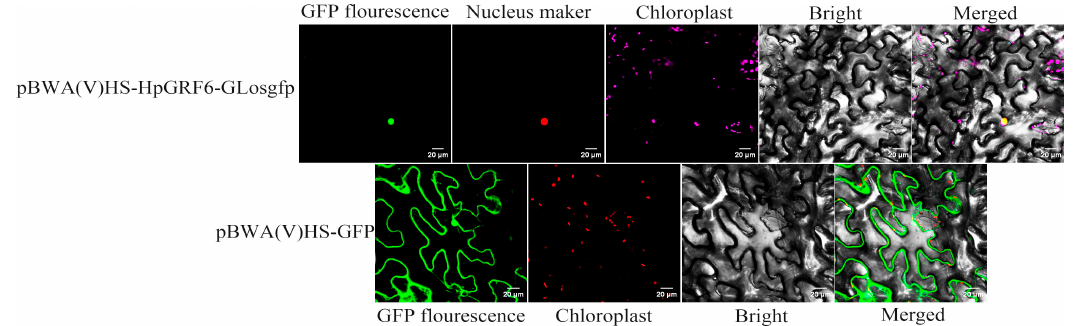
Figure 7. Subcellular localization of HpGRF6 in tobacco leaves. The construct of HpGRF6 fused with the N-terminal of green fluorescence protein (GFP; pBWA(V)HS-HpGRF6-GLosgfp) was co-infiltrated with pBWA(V)HS-GFP into tobacco leaves. The co-infiltrated leaves were photographed after 3 days. Note: GFP fluorescence (green), nucleus fluorescence (red), merged images (yellow), and bright-field chloroplast (rose red) images are shown. Scale bar = 20 μ m.